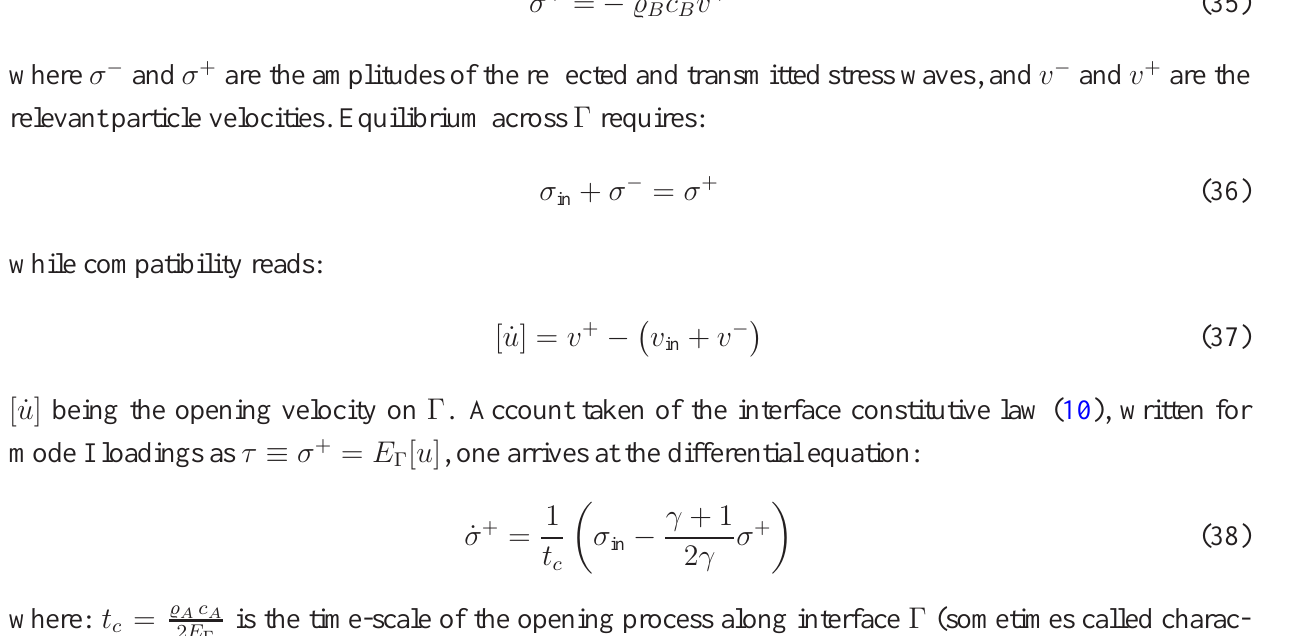
on the capability of the = η D A